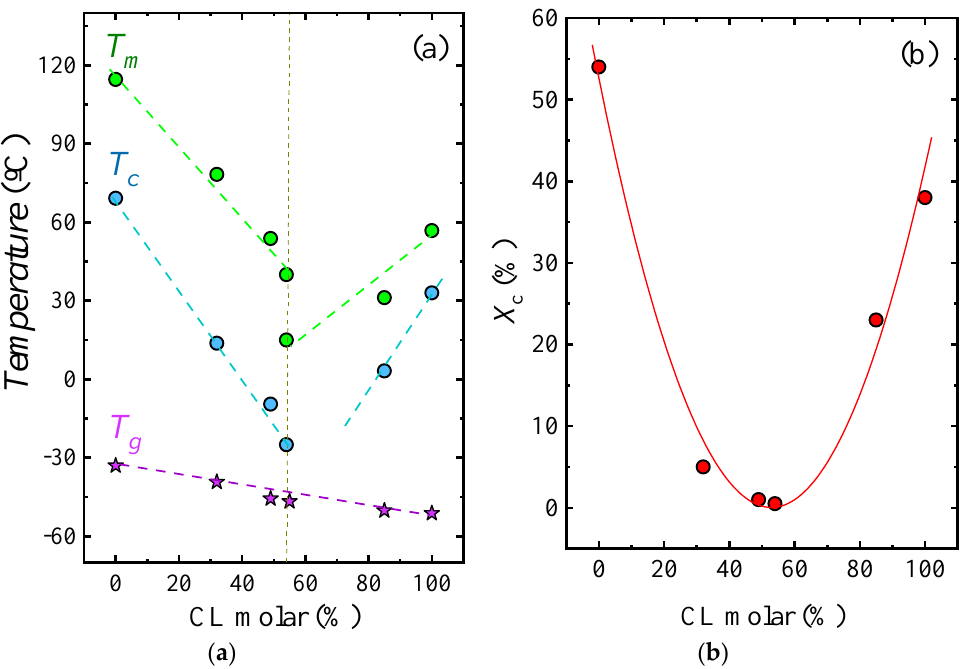
Figure 1. ( a ) Phase diagram of the HM w -BS x CL y copolymers based on non-isothermal crystallization. The short-dashed upright line specifies the pseudo-eutectic point. ( b ) Crystallization degree ( X c ) for PBS- ran- PCL copolyesters as a function of composition. These data, taken from [22], are included to facilitate the interpretation of rheological and tack results of sections 3.1 and 3.2, respectively.